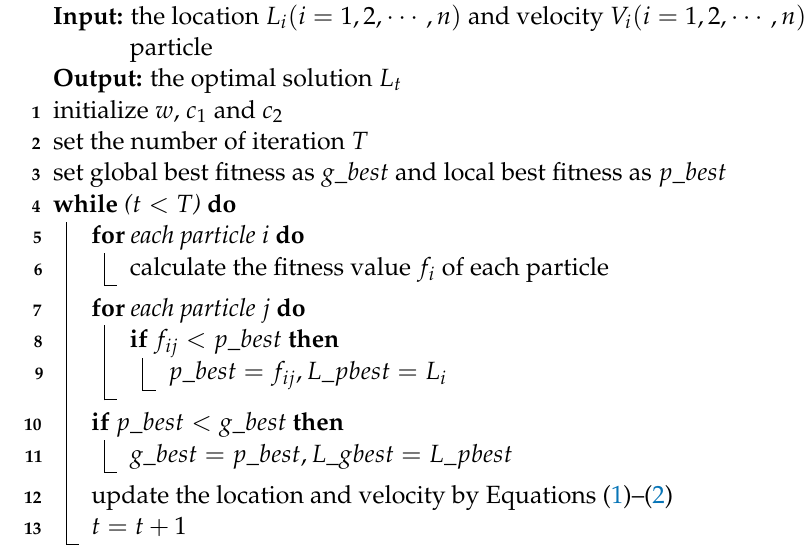
Algorithm 1: The implementation process of